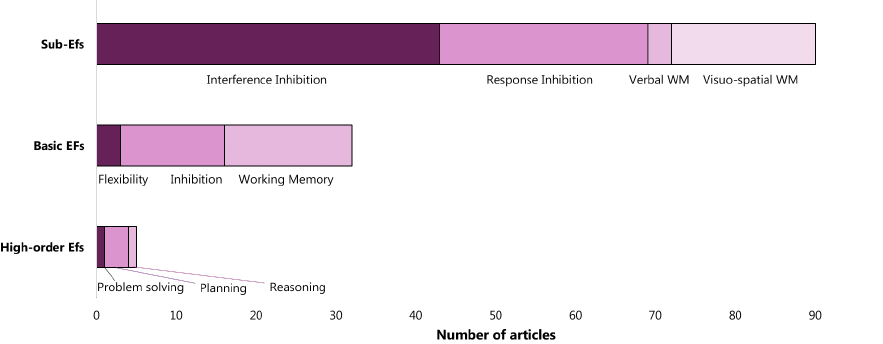
Figure 4. Number of articles per executive function considering the level of details in analysis of executive